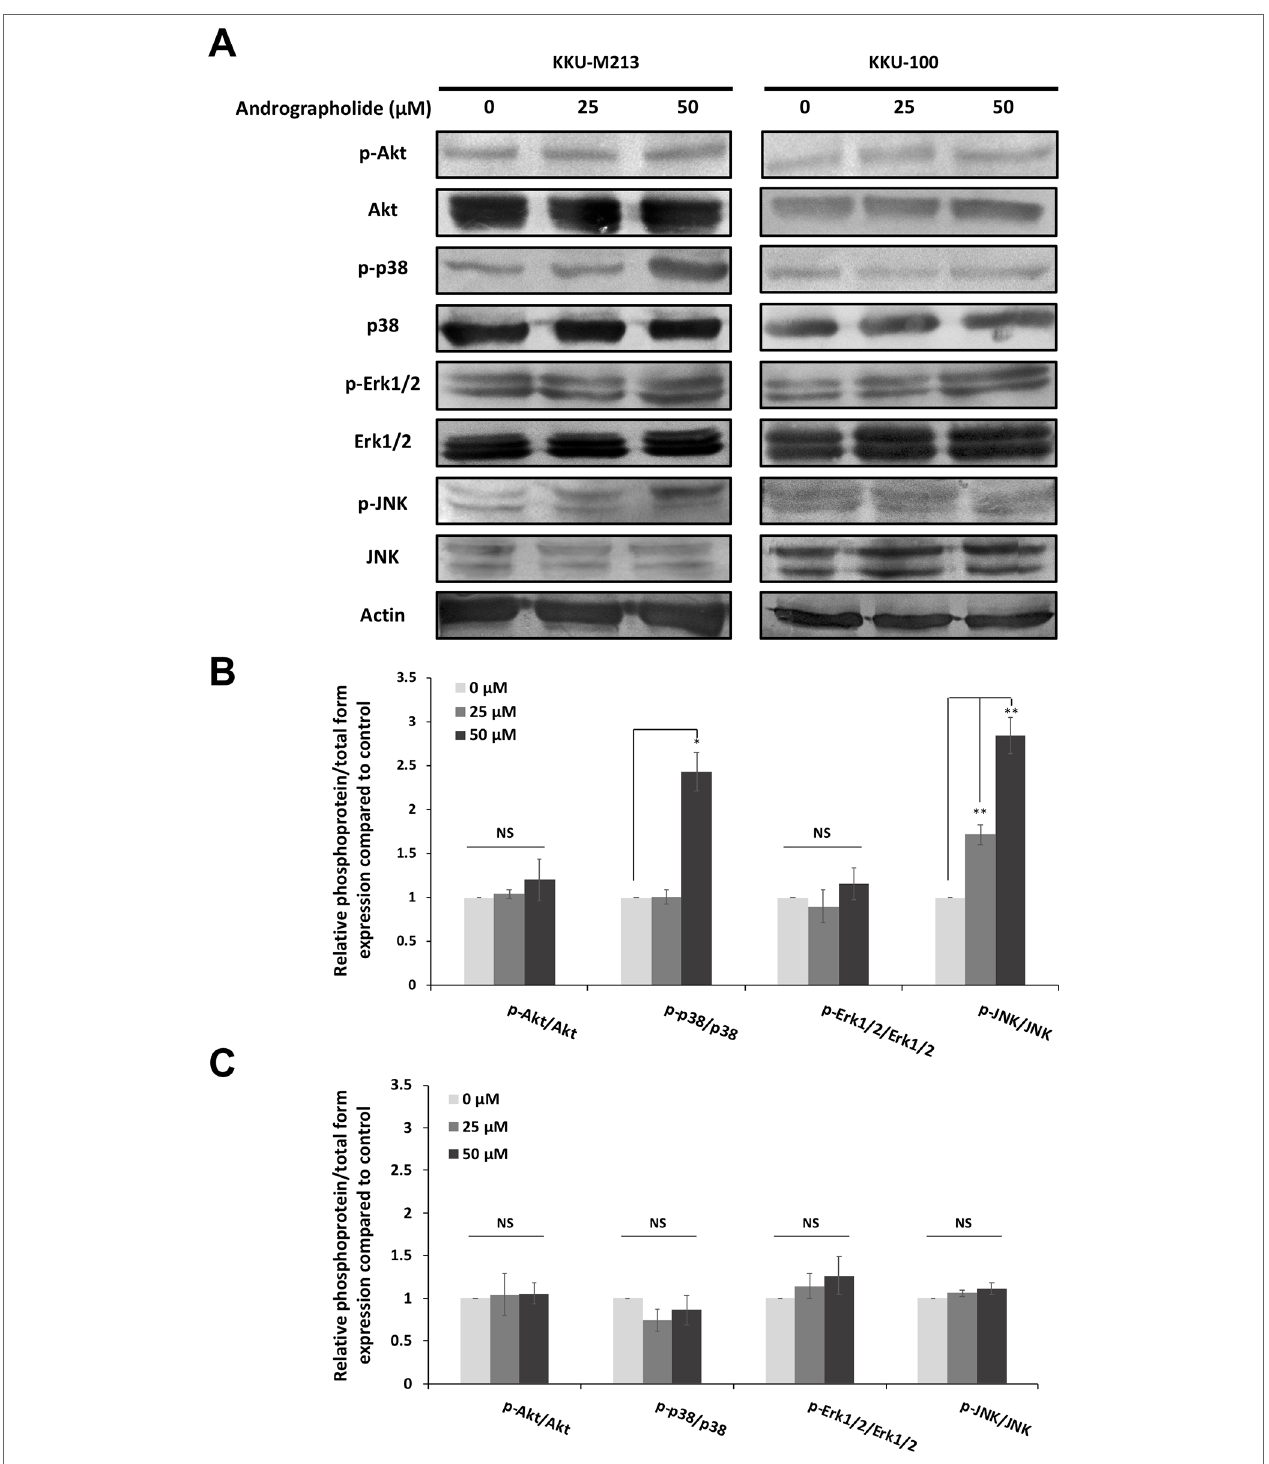
FIGURE 5 | Andrographolide induced phosphorylation of p-38 and JNK in KKU-M213 cells. (A) KKU-M213 and KKU-100 cells were treated with 0, 25, and 50 µM of andrographolide for 24 h. Cellular proteins were analyzed for the expression of phospho-Akt (p-Akt) (Ser473), Akt, and MAPK signaling pathways including phospho-p-38 (p-p-38) (Thr180/Tyr182), p-38, phospho-Erk1/2 (p-Erk1/2) (Thr202/Tyr204), Erk1/2, phospho-JNK (p-JNK) (Thr183/Tyr185), and JNK. Actin served as an internal control. The levels of protein expression in (B) KKU-M213 and (C) KKU-100 cells were quantified by intensitrometric analysis relative to the control. The results of the bar graph are represented by the average of relative intensity compared with that of the control. Data were derived from three independent experiments and are presented as mean ± SE, * p < 0.05, ** p <